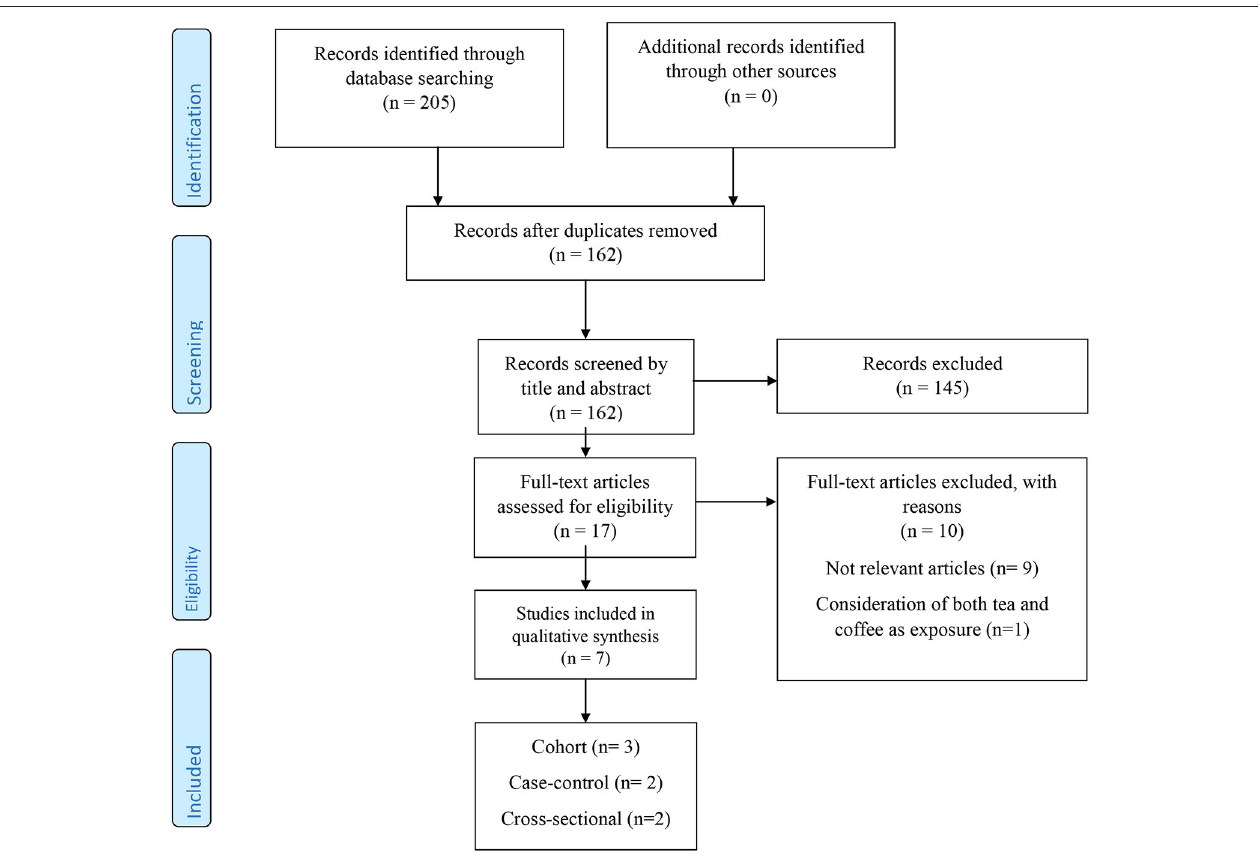
FIGURE 1 | The flow diagram of study